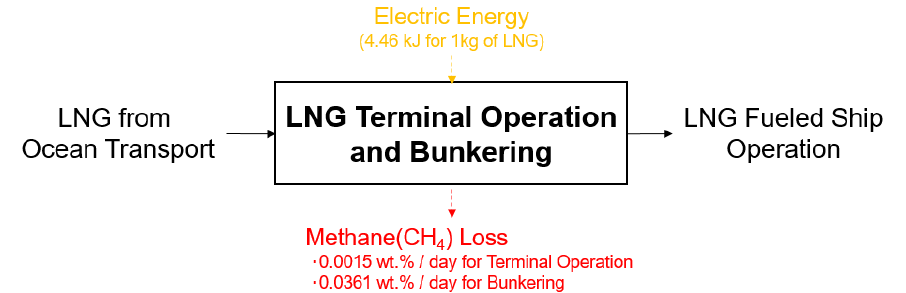
Figure 6. The LNG bunkering process for LNG in well-to-tank phase.